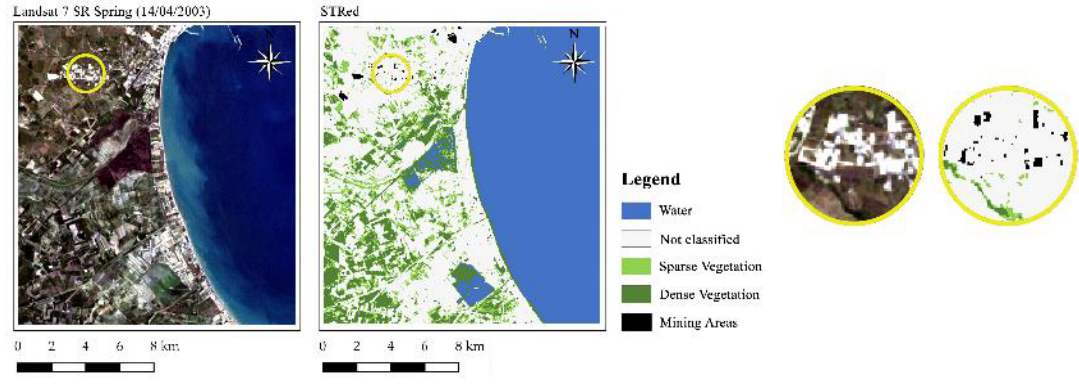
Figure 9. SwirTiRed index (STRed) classification outcome for Landsat 7 (image acquired on 14 April 2003). On the right, zoomed images with some misclassifications.